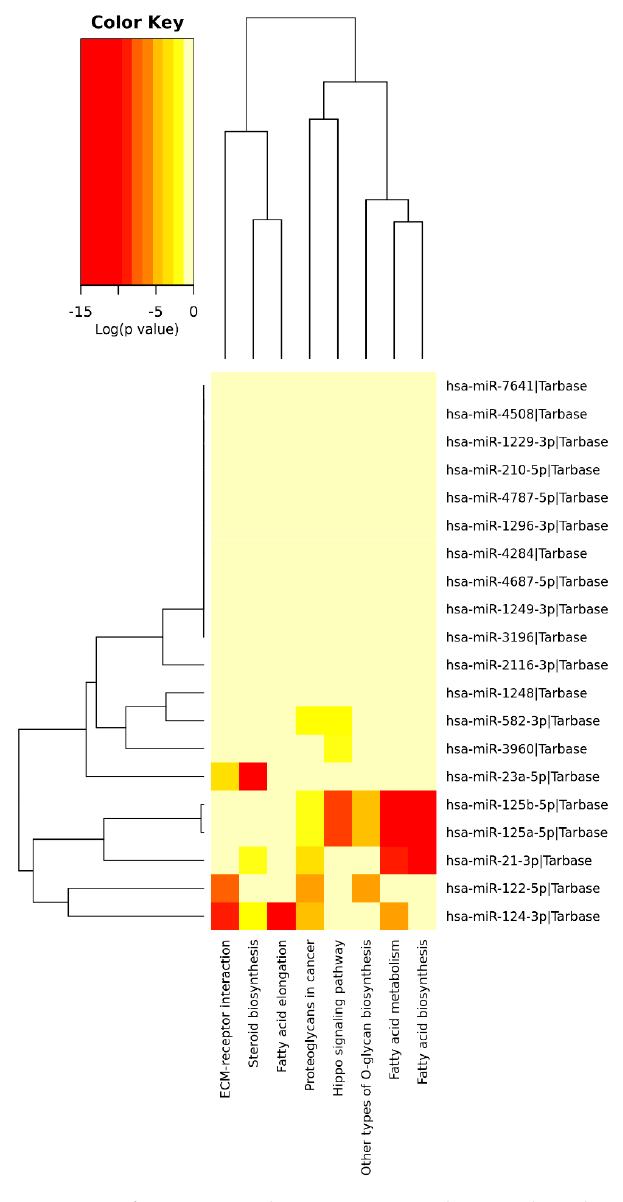
Figure 6. A heatmap viewer of a KEGG pathways union analysis with Tarbase: Overrepresented pathways by SDE miRNA targets between the CHC and SC groups with respect to HC.